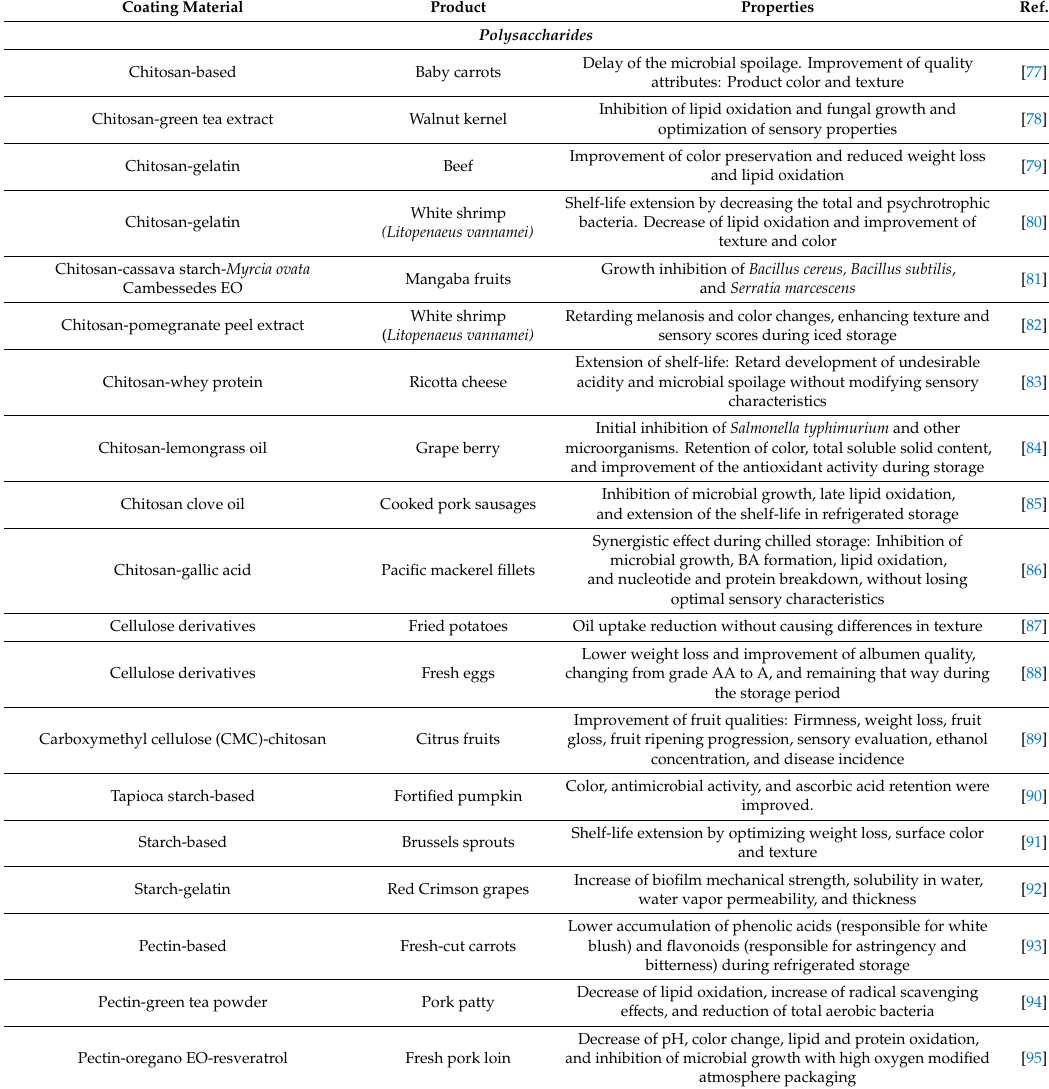
Table 2. Examples of food applications of edible films and coatings based on di ff erent edible